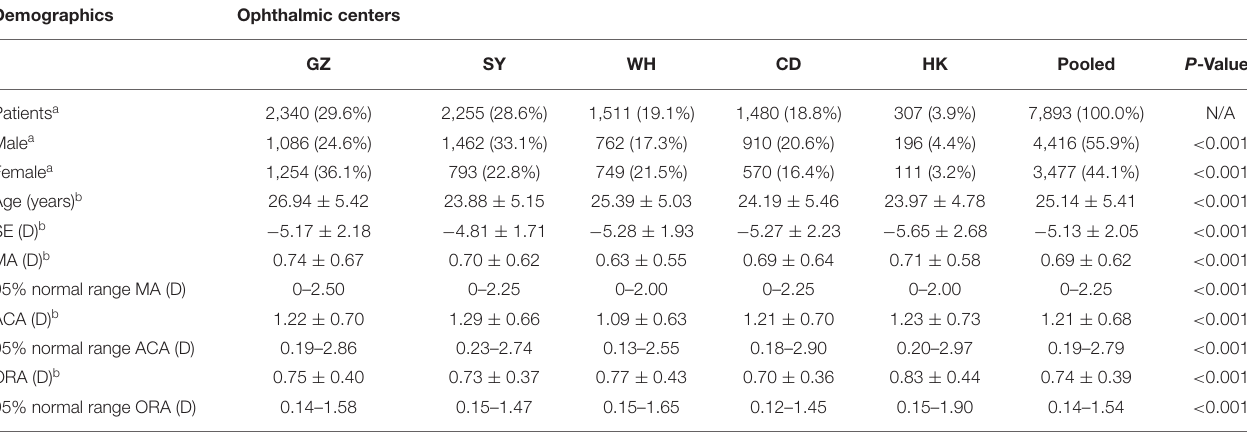
TABLE 1 | Demographics of the patients in the five ophthalmic centers.